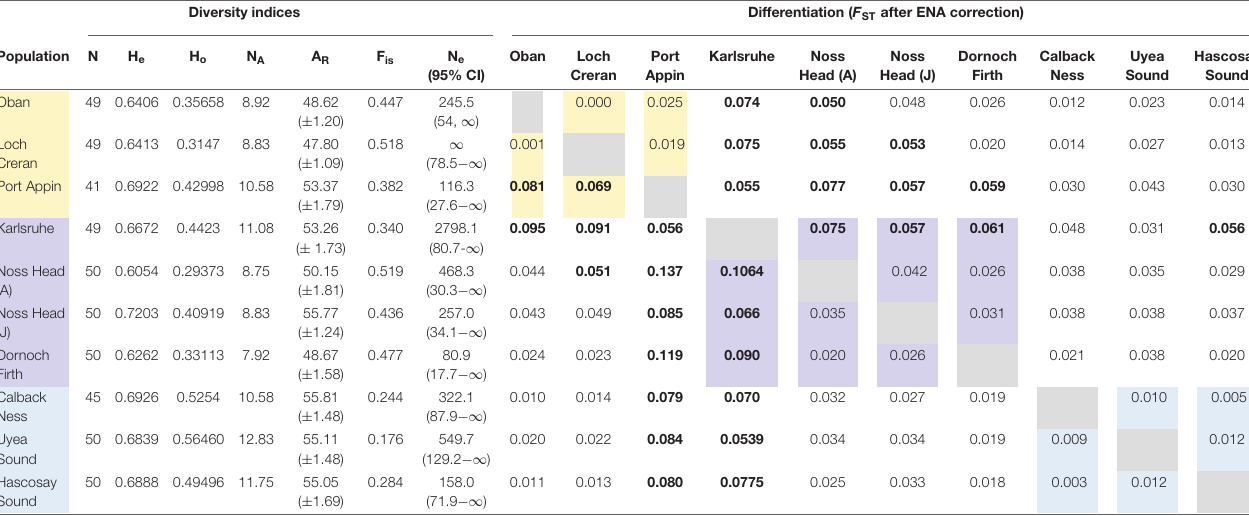
TABLE 3 | Diversity indices and differentiation values for Scottish M. modiolus reefs. Diversity indices Differentiation ( F ST after ENA correction)